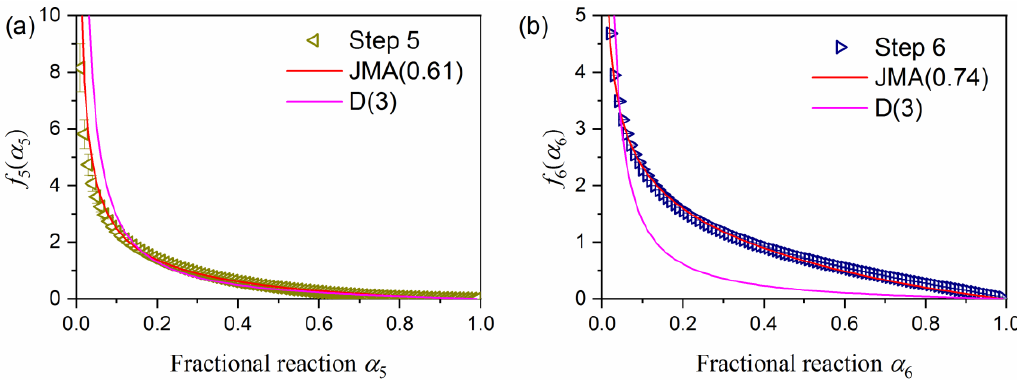
Figure 14. The plot of f i ( α i ) ( = SB( m i , n i , p i )) versus α i for the thermal decomposition step of indigo incorporated into the pores of the MB samples: ( a ) P-MB ( i = 5) and ( b ) S-MB ( i = 6).